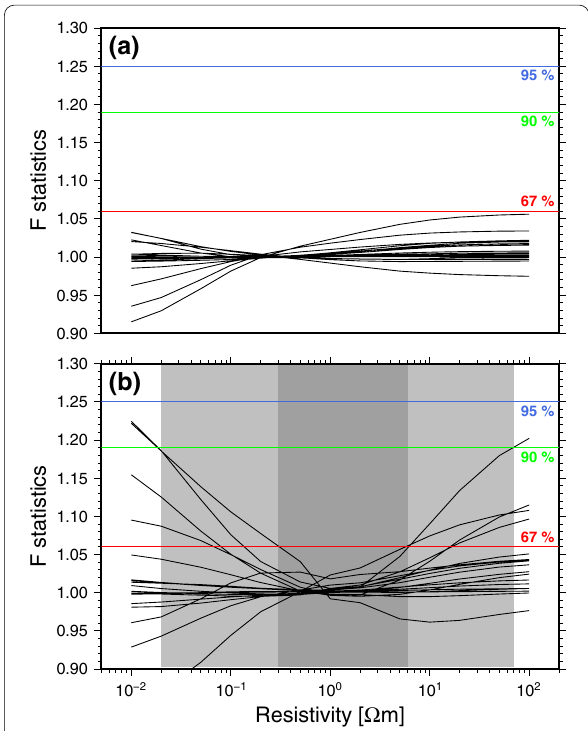
Fig. 14 F -statistic change of each site in terms of resistivity change of target area shown in Fig. 13. a F -statistic change obtained by changing resistivity inside isosurface in Fig. 13a. b Same with ( a ), but obtained by changing resistivity inside Fig. 13b. The confidence levels of 95, 90, and 67% are shown in blue, red, and green lines, respectively. The 67 to 95% CIR in a are not available. The 67% and 90% CIR in b are determined to be 0.3 to 5 Ωm (dark shade) and 0.02 to 70 Ωm (light shade),